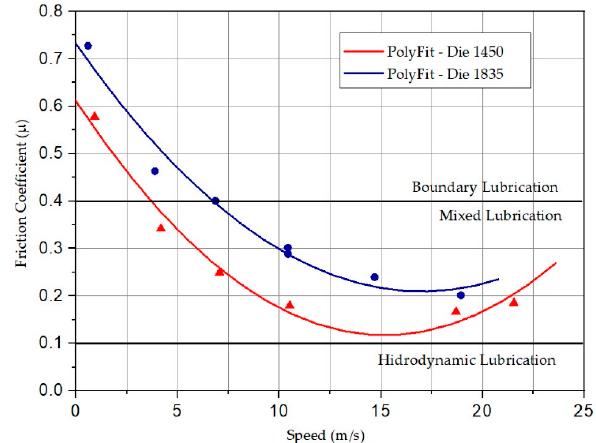
Figure 3. The friction coefficient as a function of the drawing speed for the dies 1450 and 1835. The different regimes of lubrication are separated by horizontal lines.